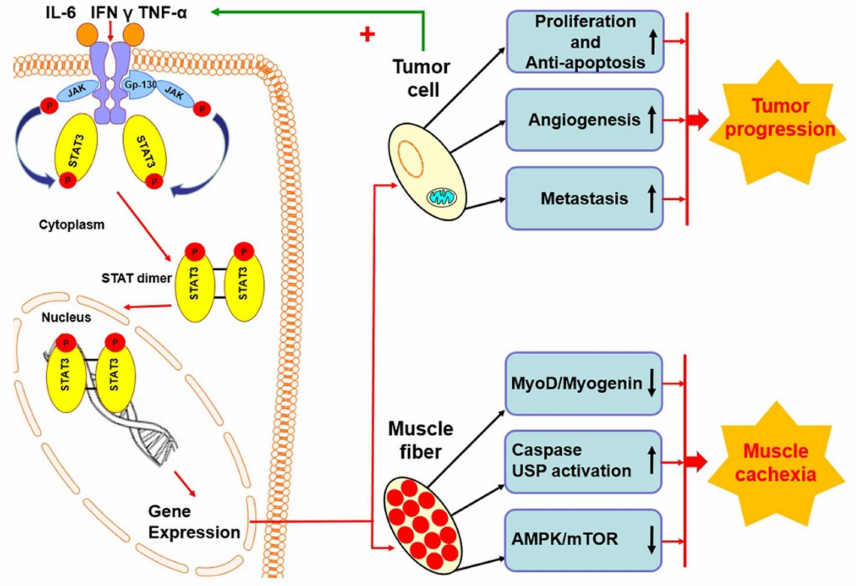
Figure 2. Comparison of the consequences of excessive STAT3 activation in muscle and cancer cells. STAT3 hyperactivity in myocytes leads to an increase (marked with an up arrow) in caspase activity, leading to universal stress proteins’ (USP) involvement. In the area of muscle tissue, a decrease in myogenin and MyoD expression (marked with a down arrow), and a weakening of the AMP-activated protein kinase (AMPK) / mTOR signal pathway were observed, which induces the process of muscle cachexia. Neoplastic cells increase the level (marked with an up) of angiogenesis, metastasis, proliferation, and inhibition of apoptosis. In this case, these events lead to the progression of the neoplastic process. On the other hand, tumor cells secrete pro-inflammatory cytokines, including IL-6, which additionally stimulate the activation of STAT3 (marked with + ), intensifying pathological changes in skeletal muscles and stimulating tumor